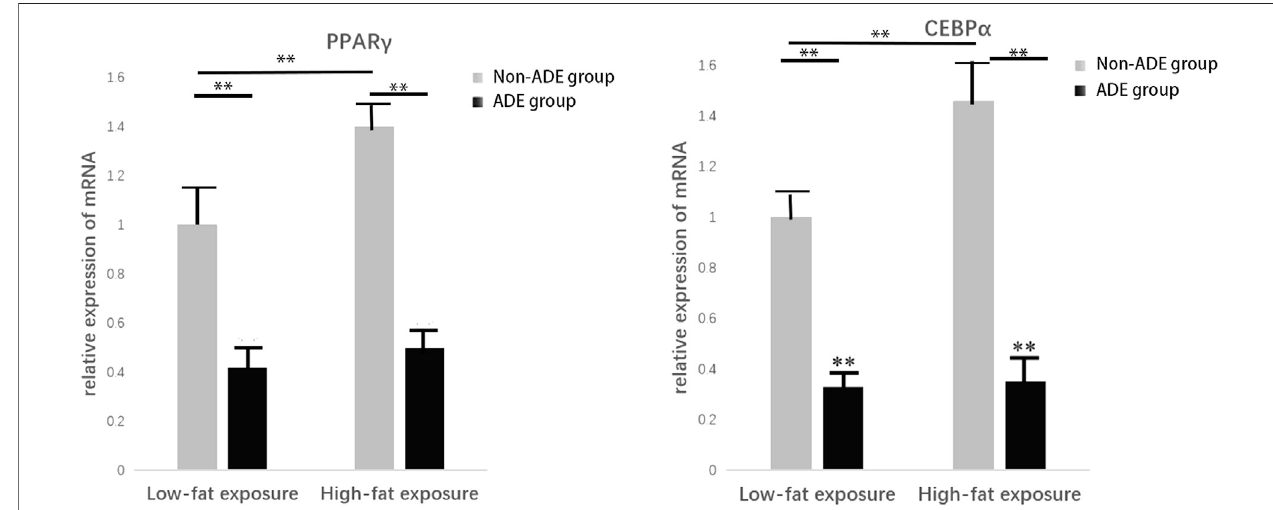
FIGURE 5 | Expression of constituent lipid markers 14 days after adipogenic induction. Expression of PPAR γ and C/EBP α was decreased in the ADE group compared tothe non-ADE group and was increased in thelow-fat exposuregroup compared tothe high-fat exposure groupwhen treated without ADEs. * p < 0.05and ** p <